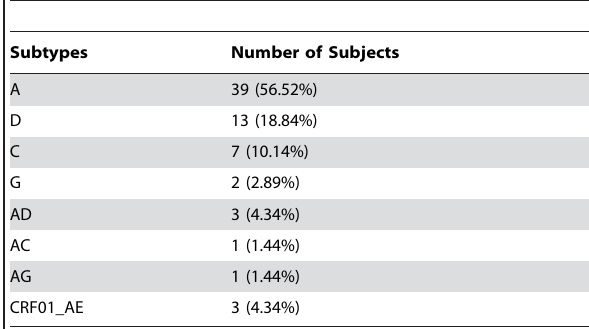
Table 2. Distribution of HIV-1 subtypes in the studied